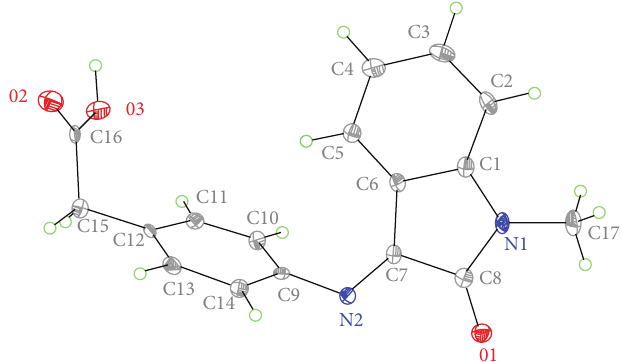
Figure 1: ORTEP diagram of compound 5b (CCDC-1004251) drawn at 50% ellipsoids for nonhydrogen